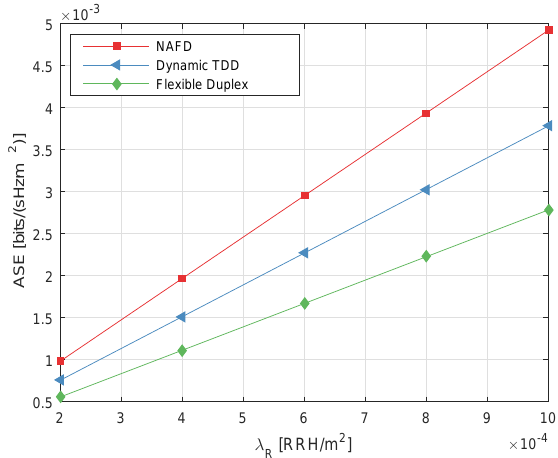
Figure 8. Average achievable rate